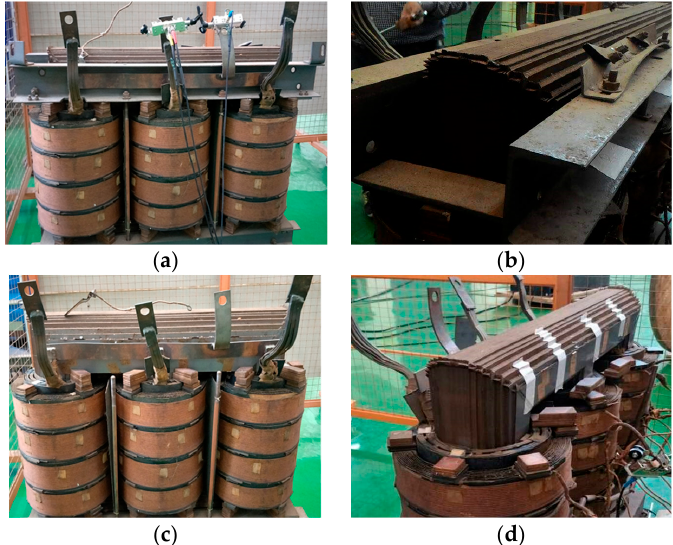
Figure 1. 500 kVA, 11/0.433 kV distribution transformer: ( a ) with top clamping—front view; ( b ) with top clamping—side view; ( c ) without top clamping—front view; ( d ) without top clamping—side view.